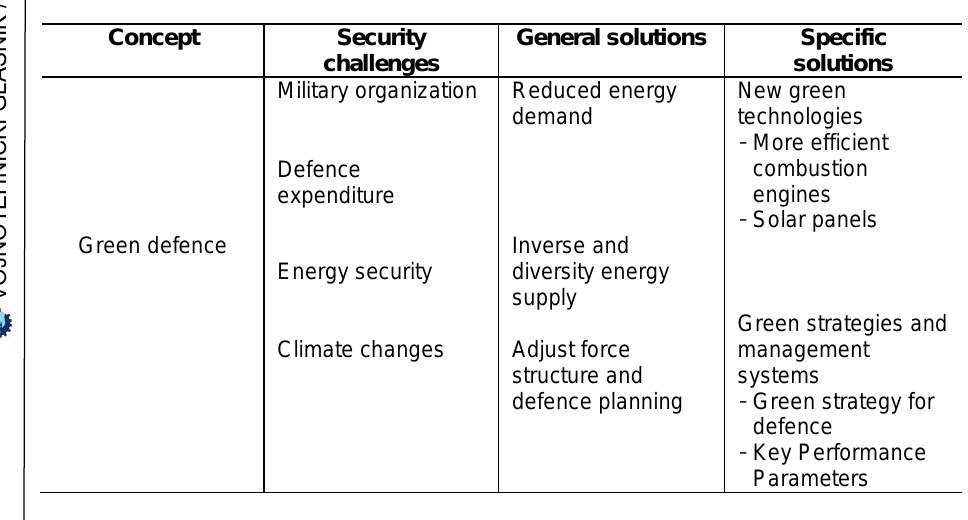
Table 1 – Green defence concept with security challenges and general and specific